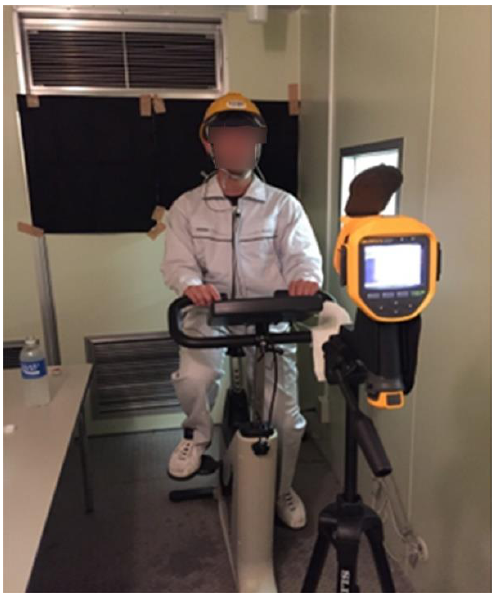
Figure 8. Experiment setup.